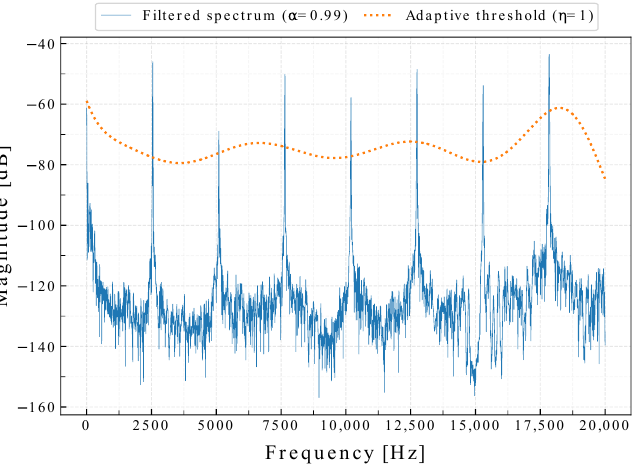
Figure 5. Filtered kINPen ® MED sound frequency spectrum, with a filter configuration: α = 0.99, and f f = 2550 Hz as well as the corresponding threshold curve. Note that the threshold generation step is completed before the filtering process and uses the unfiltered frequency spectrum